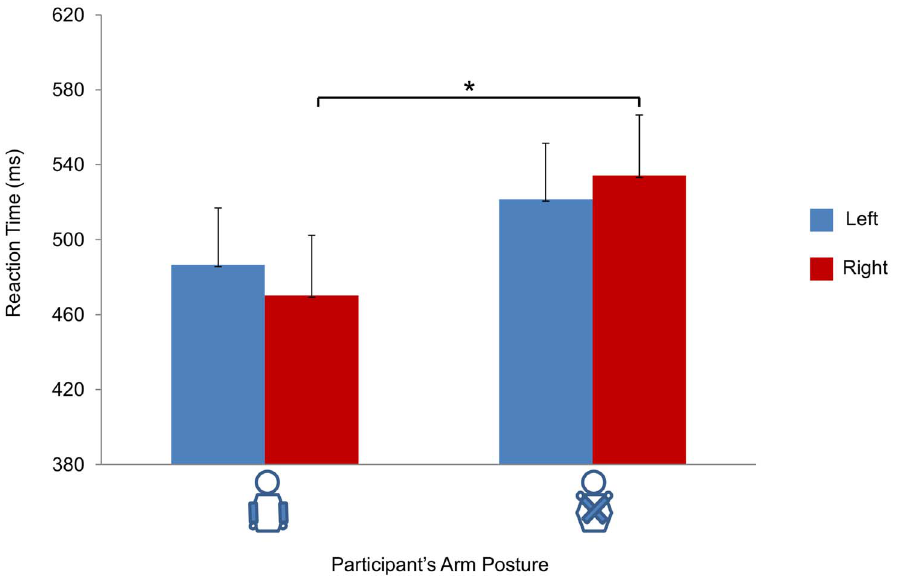
Figure 2. Results of Experiment 1 for left vs. right judgments. Graphical representation of the interaction Response (left vs. right) by Arm Posture (uncrossed vs. crossed) on Reaction Times. Bars represent standard errors of the means. Asterisks indicate significance for the main contrasts of interest ( p , 05).